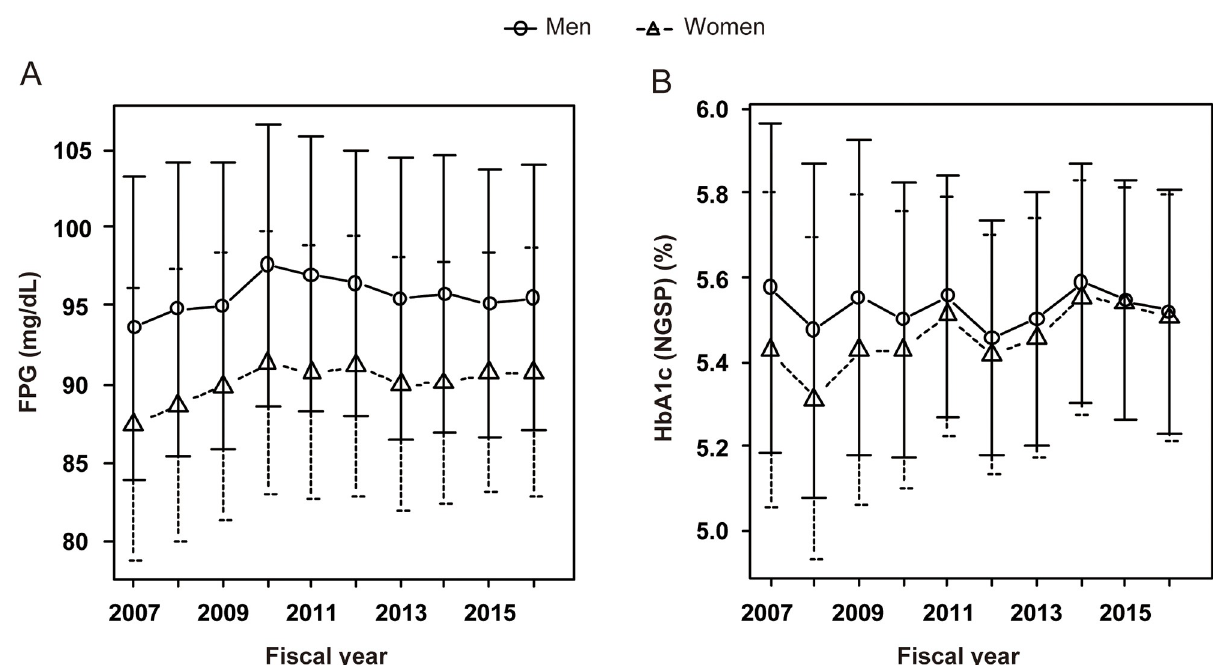
Fig 2. Results of the exploratory analysis. The annual trends in fasting plasma glucose (FPG) concentration (panel A) and glycated hemoglobin (HbA1c) level (panel B) before adjustment for background variables. Circles and solid lines represent the mean values in men and triangles and dashed lines represent the mean values in women. Error bars represent the standard deviation. See Materials and Methods for